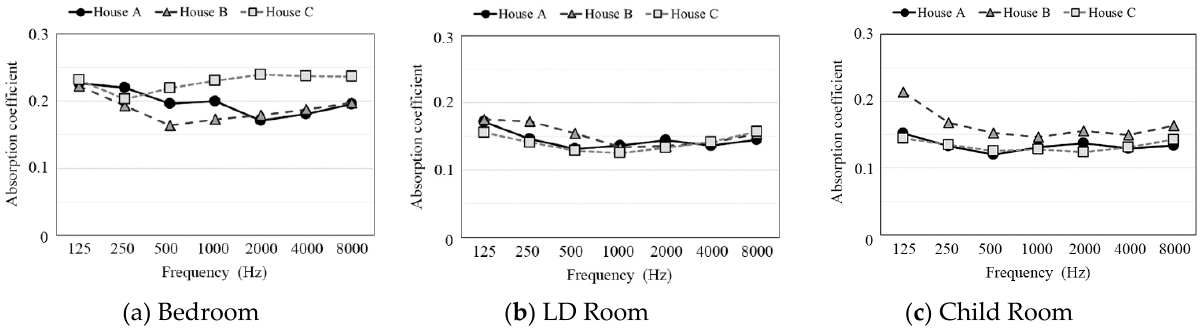
Figure 12. Frequency characteristics of the absorption coefficients in the nine rooms: ( a ) bedrooms; ( b ) LD rooms; ( c ) child rooms. Table 7. Reverberation times and absorption coefficients in the nine rooms.